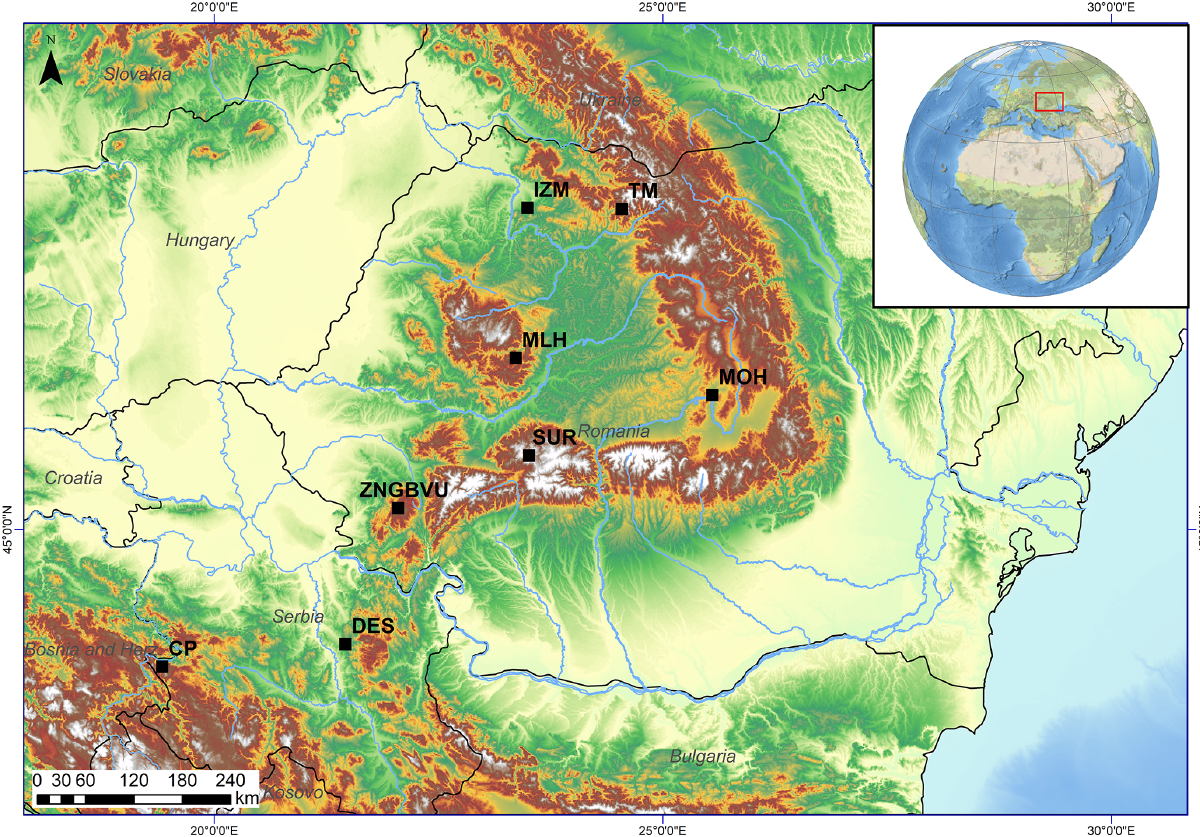
Figure 1. Map of central–eastern Europe, indicating where all of the sites used in this study are located. Study sites are marked using solid squares, and the site codes indicate the site name: Iezerul Mare (IZM), T˘aul Muced (TM), Mohos (MOH), Mluha (MLH), Sureanu (SUR),